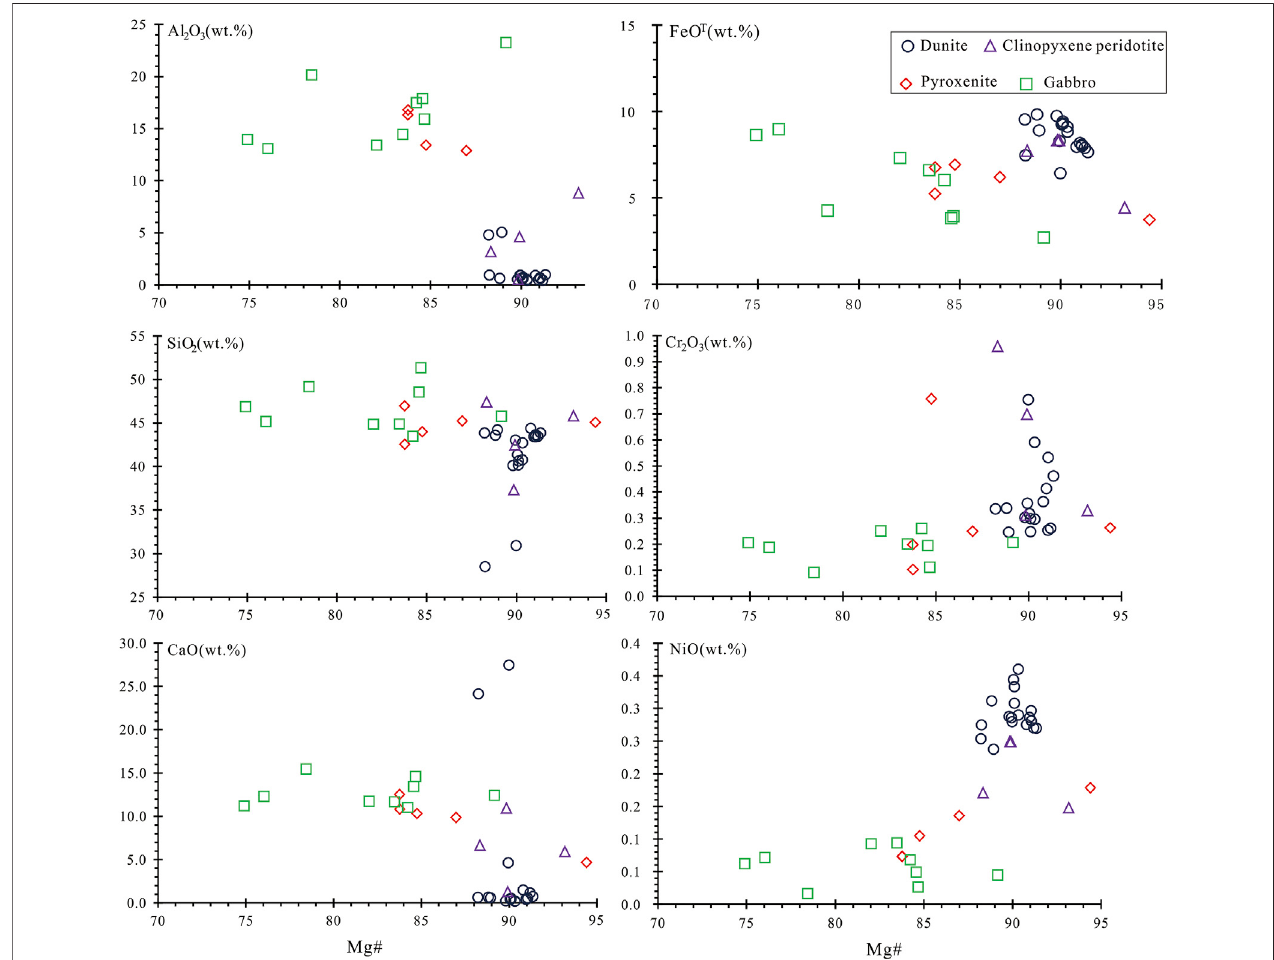
FIGURE 6 | Hark diagrams of oxides (Al 2 O 3 , FeO T , SiO 2 , Cr 2 O 3 , CaO, and NiO) vs. Mg# of the bulk-rock in the Hongshishan complex.